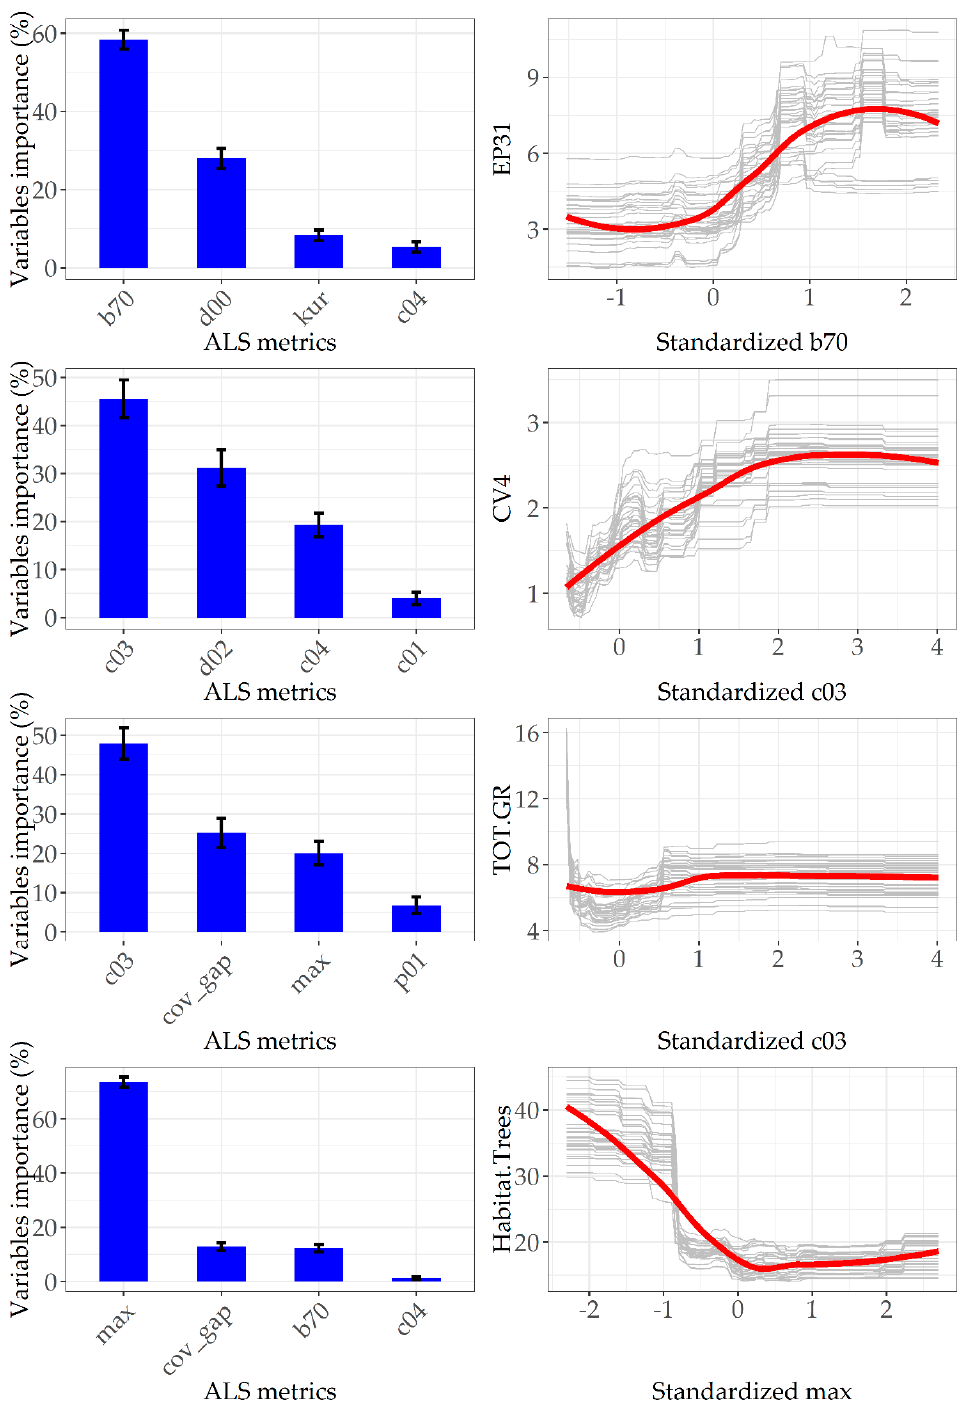
Figure 4. Variable importance (blue bars) and response curves (red lines) of the best-predicted microhabitats for each hierarchical classification. The gray curves indicate the response shapes of the 35 Random forest models derived from the five-times-repeated, seven-fold cross-validation, while the red curves show their average tendencies as calculated by a Loess